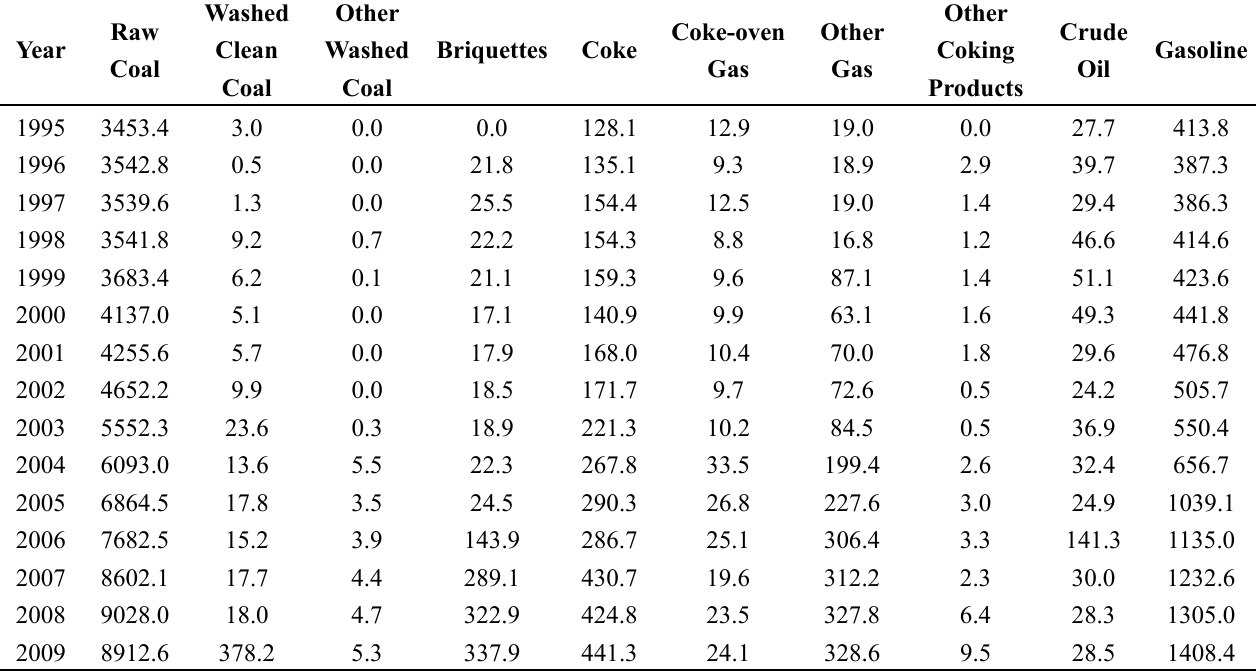
Table A1. Energy consumption by types (10 4 ton standard coal